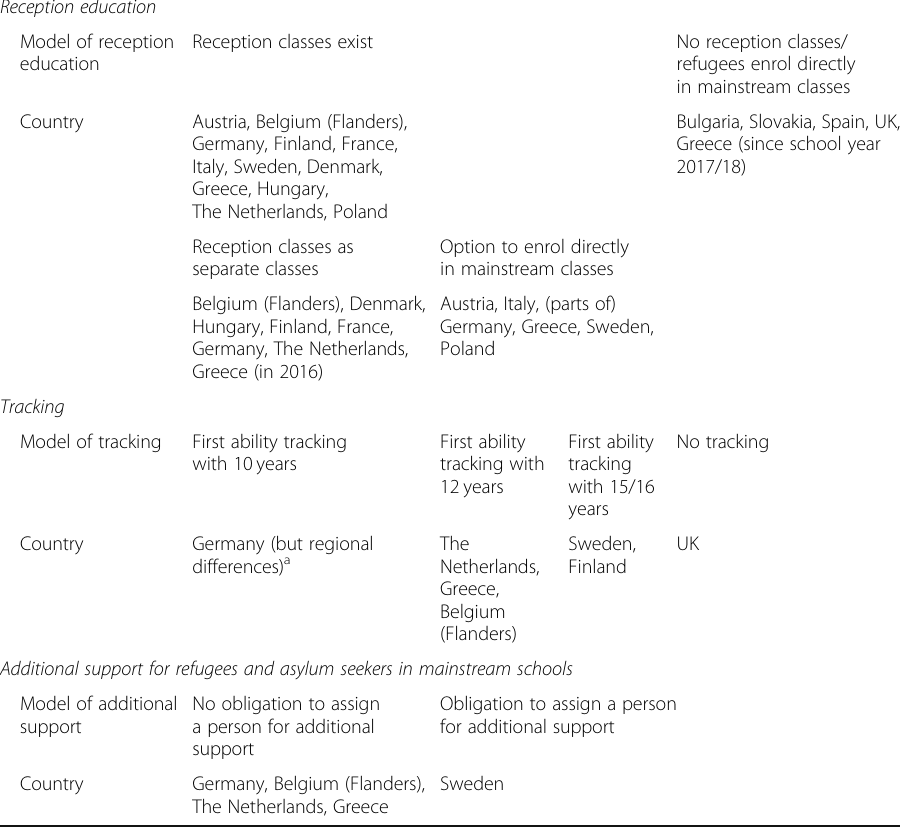
Table 1 Overview of systemic differences in the education of refugees in selected EU countries Reception